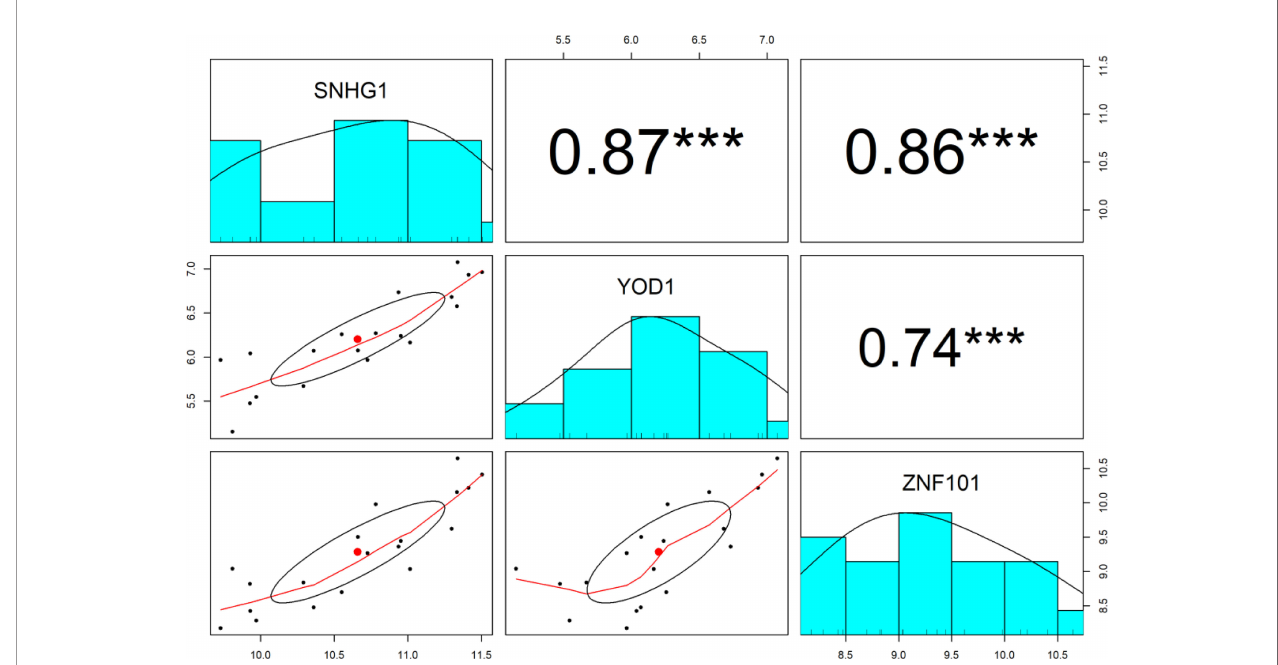
FIGURE 4 | The distribution of each variable is shown on the diagonal. The lower portion of the diagonal shows bivariate scatter plots with a fi tted line. On the upper part of the diagonal, the correlation coef fi cients plus the signi fi cance level as stars are displayed. *** is signi fi cant correlation at P -value < 0.001.